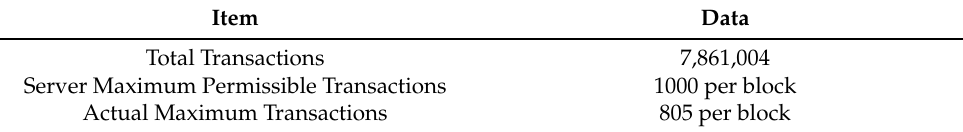
Table 8. System Performance Measurements(from 17 June 2019 to 31 August